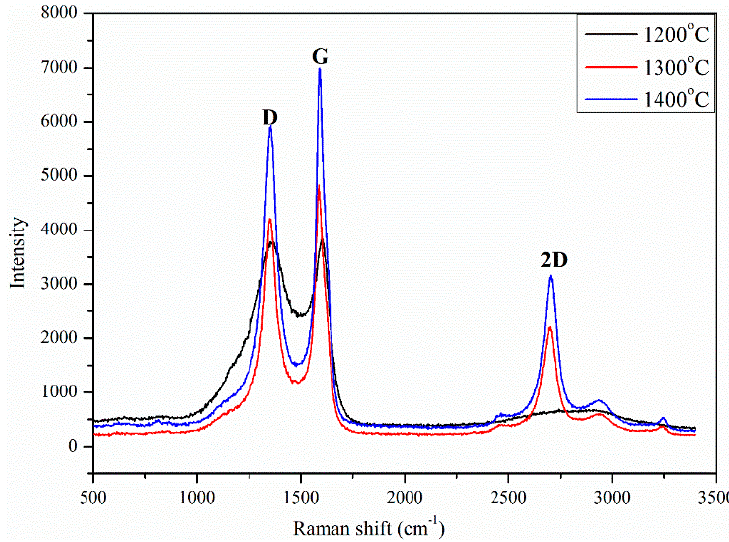
Figure 7. Raman spectra of SL-CNTs as a function of synthesis temperature.